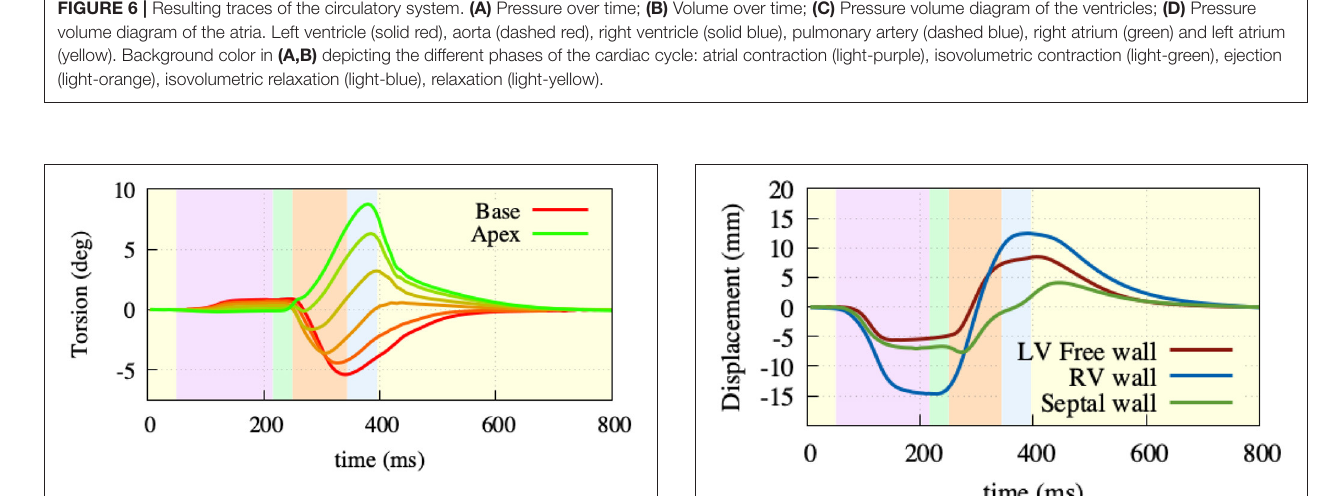
FIGURE 7 | Twisting motion measured at 5 points of the left ventriclular free wall. During atrial contraction (light-purple) and isovolumentric contraction (light-green), the apex shows a clockwise and the base a counterclockwise rotation. Throughout the ejection (light-orange) phase, the rotational direction switches to a counterclockwise rotation in the apex and clockwise rotation in the base. Afterwards, both base and apex go back to their initial state as part of the relaxation.